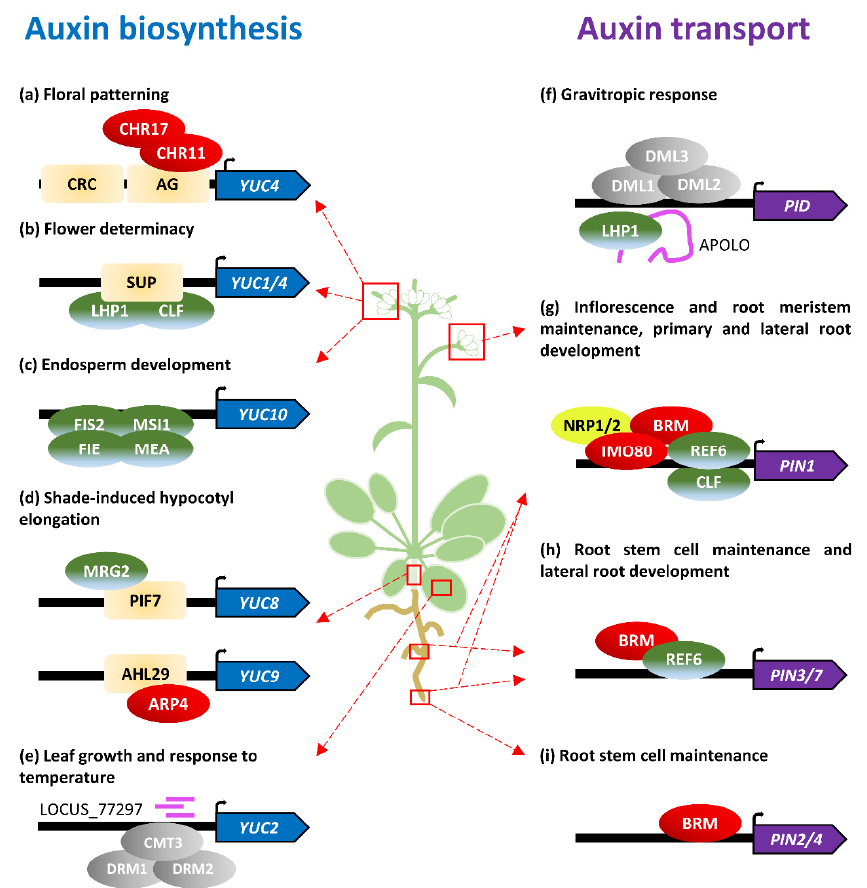
Figure 1. Auxin biosynthesis and transport are epigenetically regulated along the plant life cycle. ( a – h ) Epigenetic regulation of ( a – e ) auxin-biosynthesis-related genes and ( f – i ) auxin-transport-related genes. Colored ovals represent proteins of the epigenetic machinery: chromatin remodelers (red), Polycomb and other histone modifiers (green), DNA methylation / demethylation enzymes (grey), histone chaperones (yellow), and noncoding RNAs (pink). Pale orange rectangles indicate transcription factors. Proteins promoting gene activation are represented above the gene, whereas factors drawn below represent repressors. Distances to the regulated gene are not drawn to